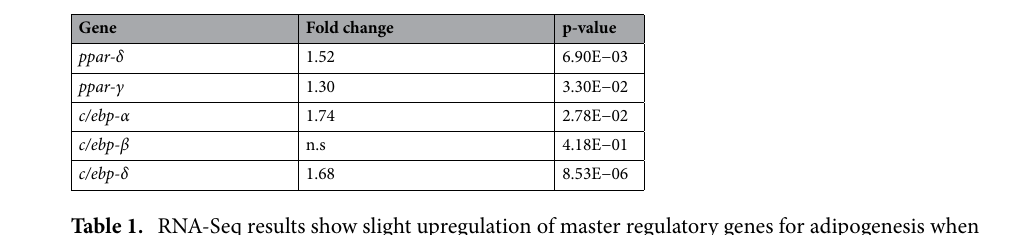
Table 1. RNA-Seq results show slight upregulation of master regulatory genes for adipogenesis when comparing non-ciliated and ciliated 3T3-L1 samples. n.s . Not significant.